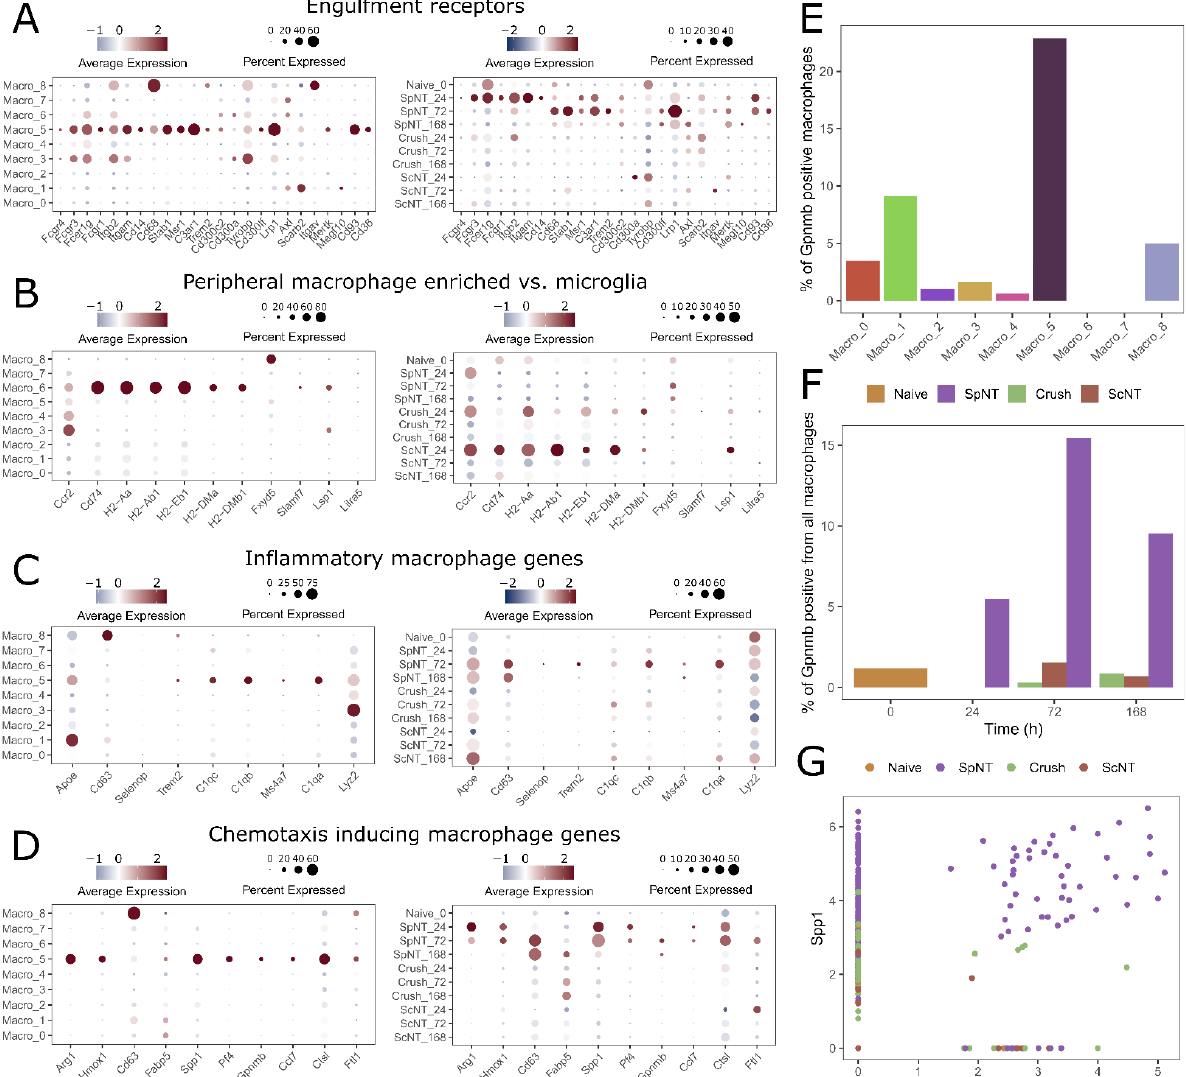
Figure 5. Macrophages from different tissues have distinct transcriptomic profiles and exhibit remarkable heterogeneity. ( A ) DRG macrophage expression of the phagocytosis-related engulfment receptors. Left panel shows the expression for each macrophage cluster and right panel shows the expression for each PNI model and time point. ( B ) DRG macrophage expression of the peripheral macrophage genes. ( C ) DRG macrophage expression of the inflammatory genes. ( D ) DRG